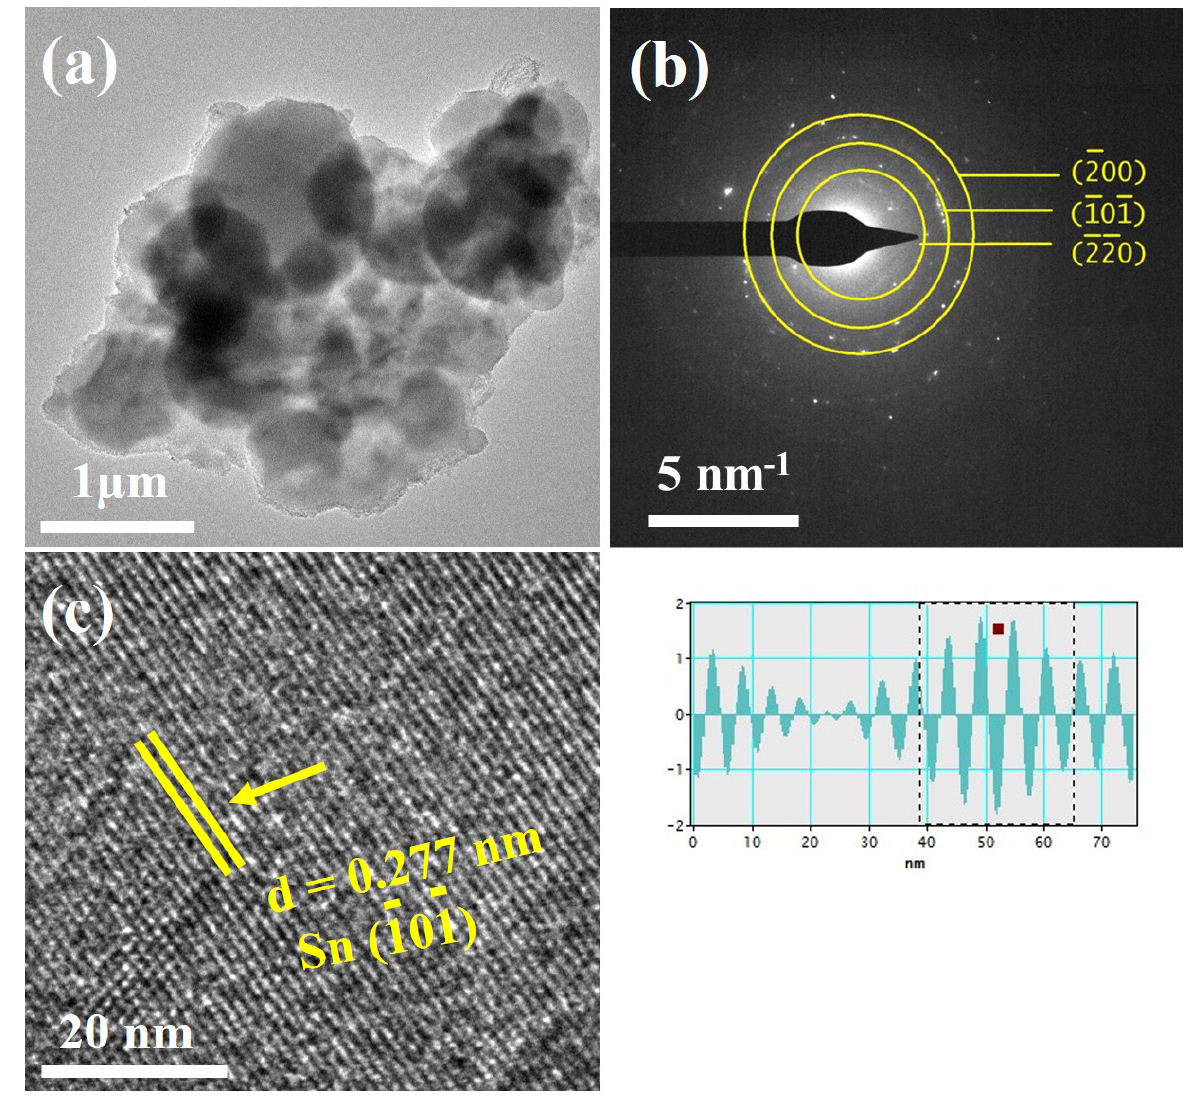
Figure 3. ( a ) TEM image of the Sn/C composite; ( b ) SAED pattern of the composite; ( c ) HRTEM- enlarged image of the composite.